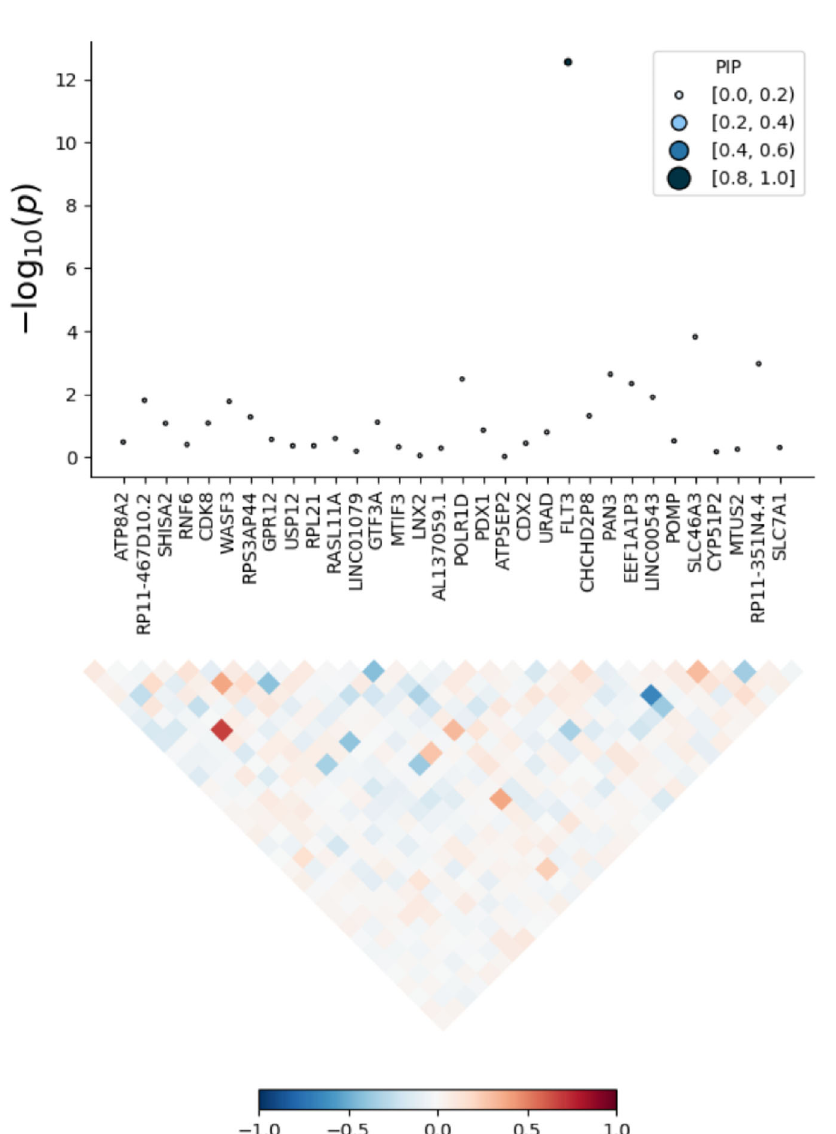
Fig. 1 Fine mapping of chromosome 13 TWAS signal. PIP is the posterior inclusion probability. TWAS p values derived from FOCUS are on the Y -axis and genes within the locus are on the X -axis. The local correlation structure is shown in the bottom half of the fi gure. The PIP for FLT3 was the